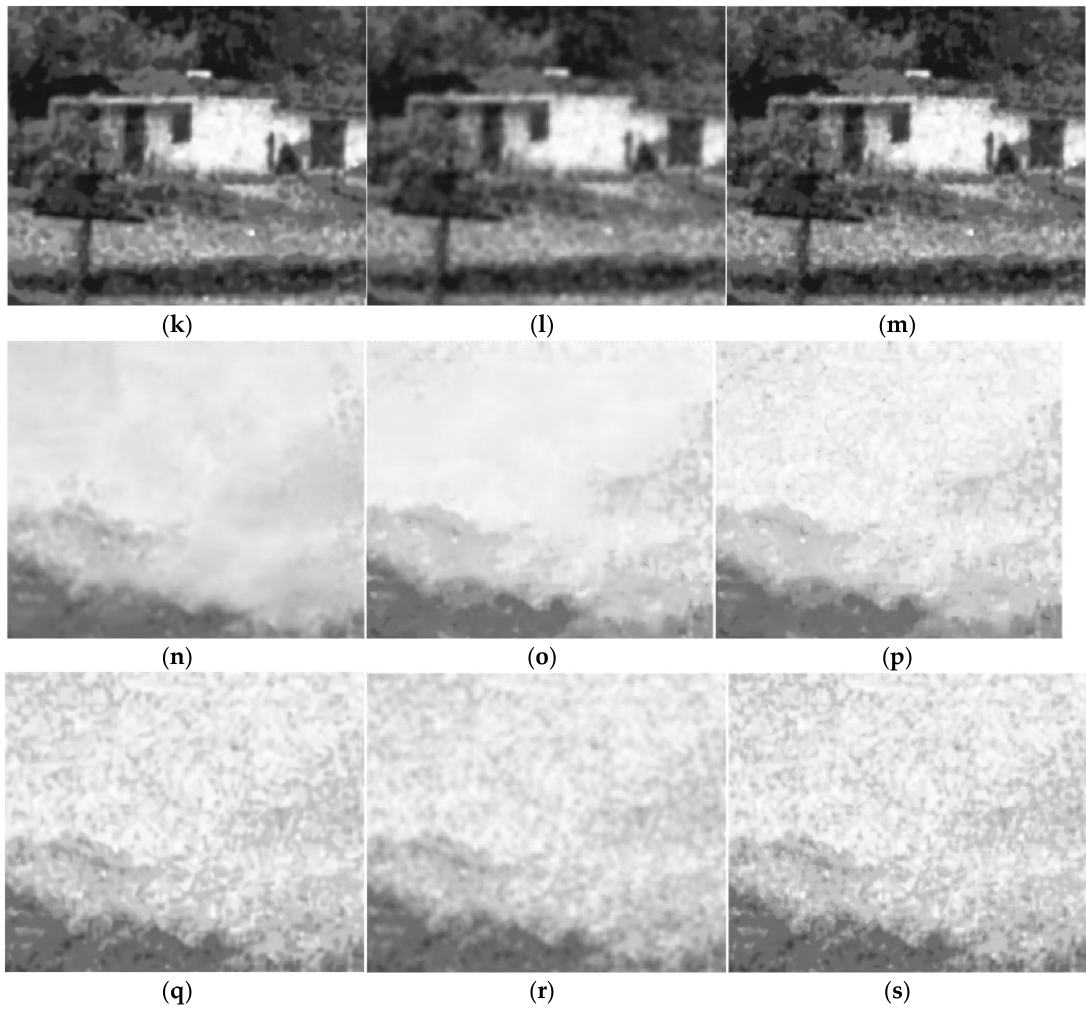
Figure 5. The subjective results of the proposed algorithm and other baselines. ( a ) the patches in the noisy ICCD image; ( b , h , n ) the result of the denoising algorithm in [2]; ( c , i , o ) the result of the proposed algorithm; ( d , j , p ) the result without the RPCA in Section 4.5; ( e , k , q ) the results of BM3D; ( f , l , r ) the result of K-SVD; ( g , m , s ) the results of BLS-GSM.